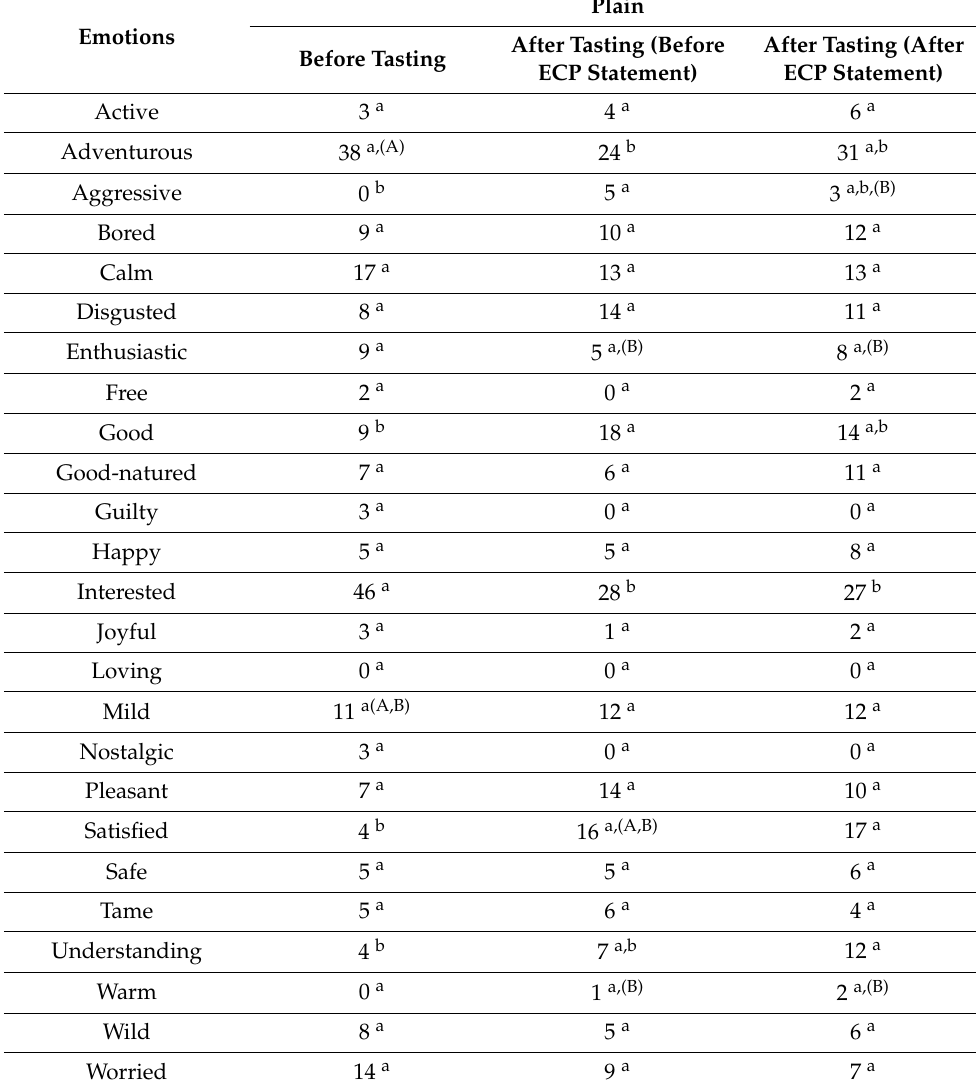
† Frequency of emotions for the plain treatment across moments (before tasting, after tasting, and after edible cricket protein (ECP) statement) from n = 84 consumers analyzed by two-sided Cochran’s Q test with Marascuilo and McSweeney procedure. Different lowercase/uppercase letters within a row represent significant ( p < 0.05) dif- ferences across moments for the plain treatment/treatments (Tables 5 and 6) within a given moment. ‡ Treatments are described in Figure